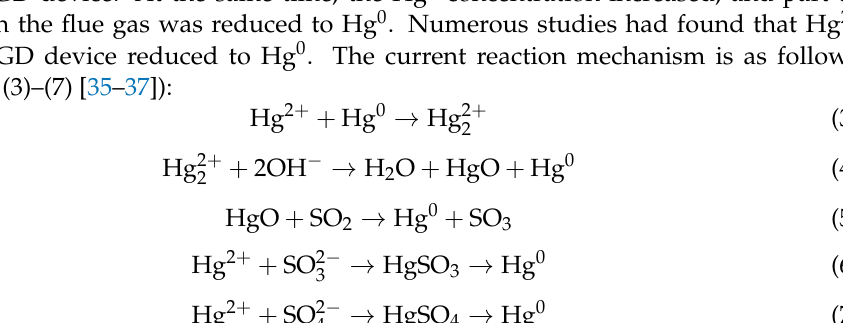
Table 5. Concentrations of Hg 0 and Hg 2+ at the inlet and outlet of different units of devices. Evaporation Location